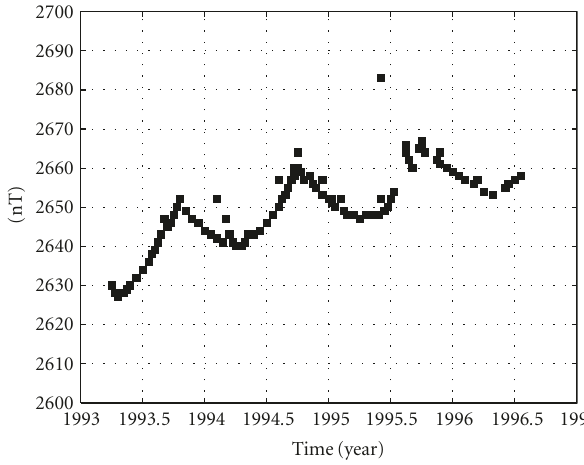
Figure 1: Geomagnetic variation of one day recorded by Kakioka Observatory, Japan.